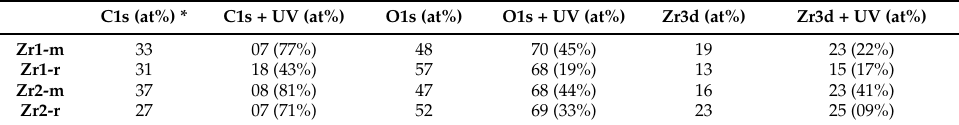
Table 2. The detailed XPS spectra of C1s, O1s and Zr3d show that UV-light treatment decreased the atomic percentage of carbon and increased the amount of oxygen and Zr3d on smooth and roughened surfaces.